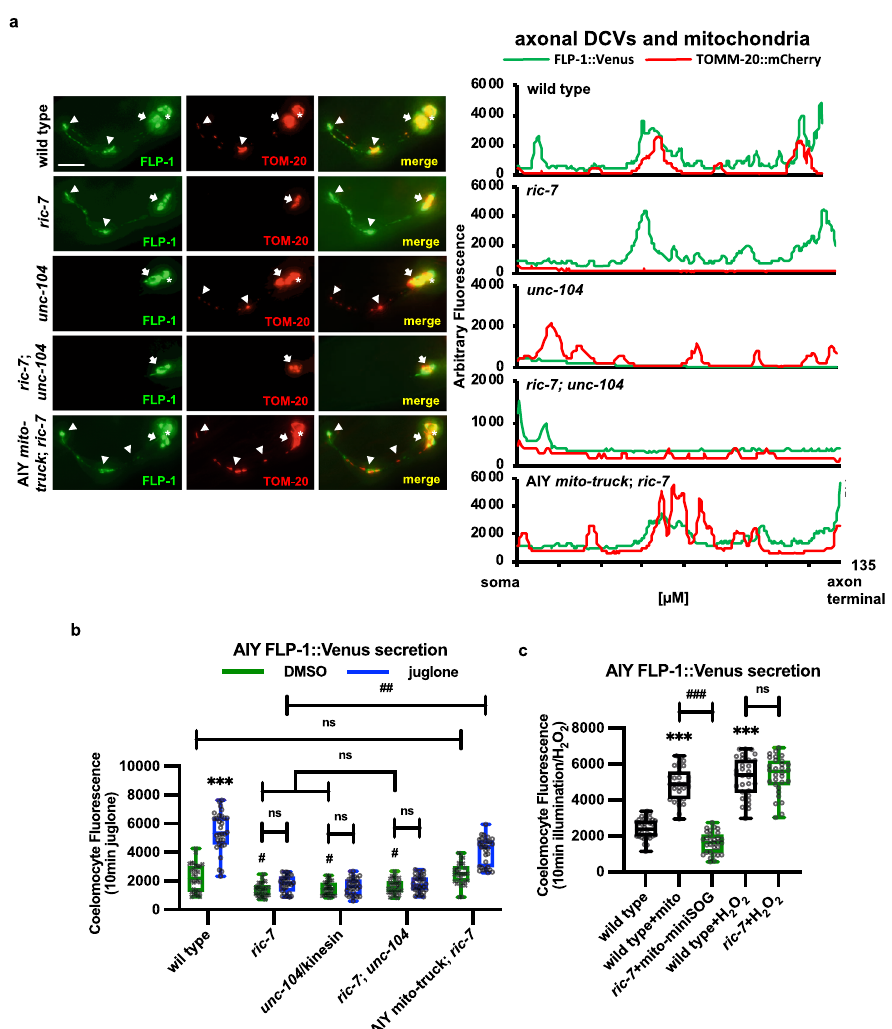
Fig. 6 Traf fi cking of mitochondria and DCVs to AIY axons is required for juglone-induced FLP-1 secretion. a Representative images and linescans of fl uorescence distribution in AIY axons of animals co-expressing FLP-1::Venus (to mark DCVs) and TOMM-20::mCherry (to mark mitochondria) in the indicated mutants. Arrowheads mark fl uorescent puncta in AIY axons and arrows mark AIY somas. Scale bar: 10 μ m. b Quanti fi cation of average coelomocyte fl uorescence intensity of the indicated mutants expressing FLP-1::Venus in AIY following 10 min juglone treatment. The boxes span the interquartile range, median is marked by the line and whiskers indicate the minimum and the maximum values. n = 30 biologically independent samples. *** P < 0.001 by Student ’ s two-tailed t -test. ## P < 0.01, n.s not signi fi cant by one-way ANOVA with Dunnett ’ s test. c Quanti fi cation of average coelomocyte fl uorescence intensity of the indicated mutants expressing FLP-1::Venus in AIY following 10 min H 2 O 2 treatment or 1 min mito-miniSOG activation. The boxes span the interquartile range, median is marked by the line and whiskers indicate the minimum and the maximum values. n = 30 biologically independent samples. *** P < 0.001 by Student ’ s two-tailed t -test. ### P < 0.001, n.s not signi fi cant by one-way ANOVA with Dunnett ’ s